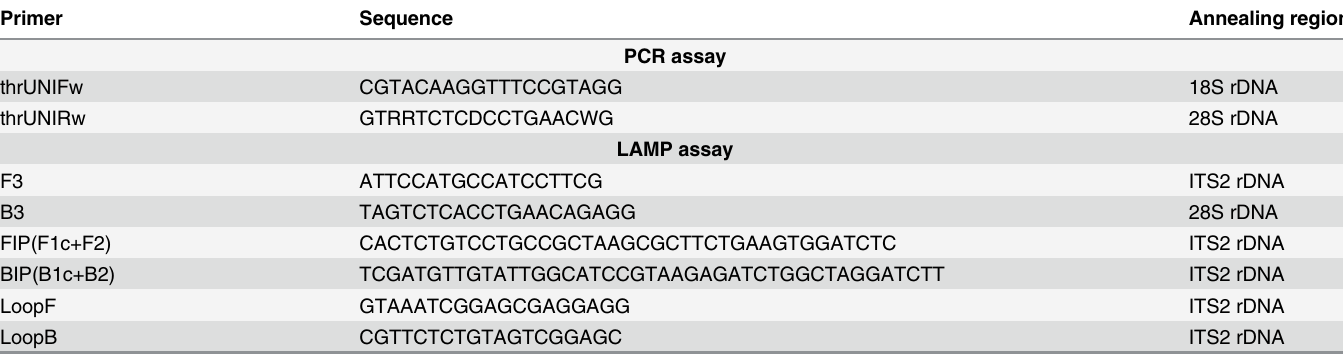
Table 2. Primers used in the PCR reactions and LAMP